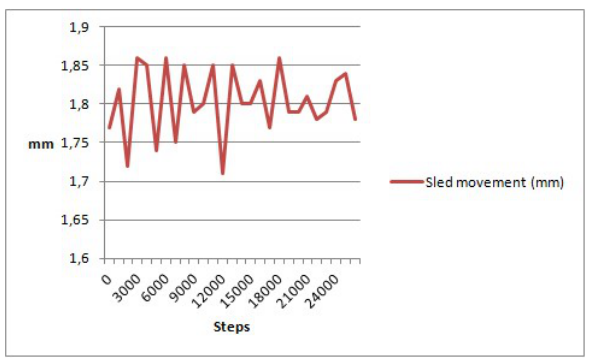
Figure 12. The repeatability test of the camera sled. The camera was moved 27 times for 1000 motor steps each resulting in an average movement of 1.8033 mm.